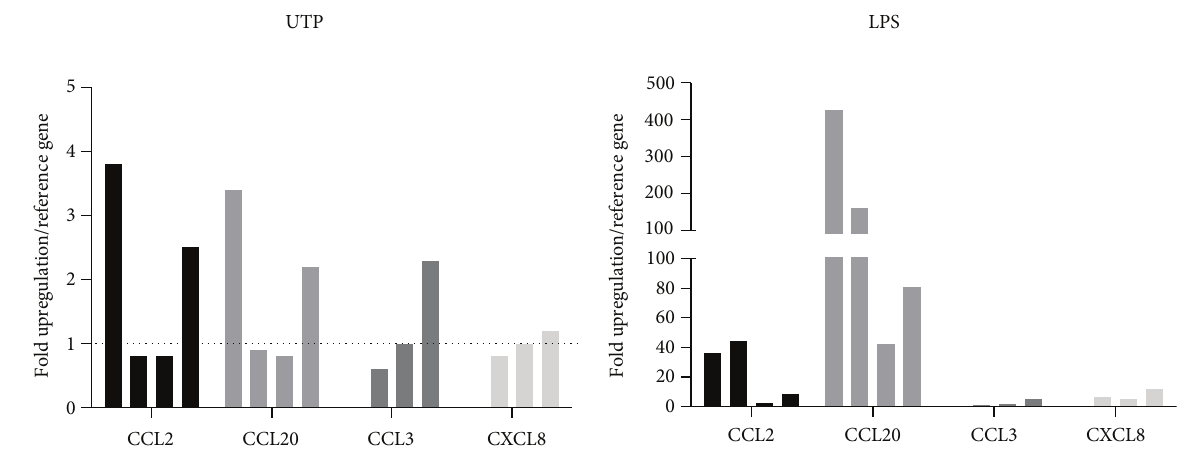
Figure 6: UTP induces chemokine gene transcription in human monocytes. Human CD14 + monocytes were plated in RPMI media containing 1% serum and stimulated with media alone, LPS (1 𝜇 g/mL), UTP (10 𝜇 M), or UDP (10 𝜇 M) for 6 hours. RNA was extracted, reverse transcribed to cDNA, and probed with quantitative PCR primers for chemokines (CCL2, CCL20, CCL3, and CXCL8) and reference gene ( 𝛽 -actin). PCR was performed in triplicate using a Rotorgene 2000. Data was analysed using the 2 −ΔΔ Ct method using a threshold of 0.003 and fold upregulation with respect to the media control is plotted.